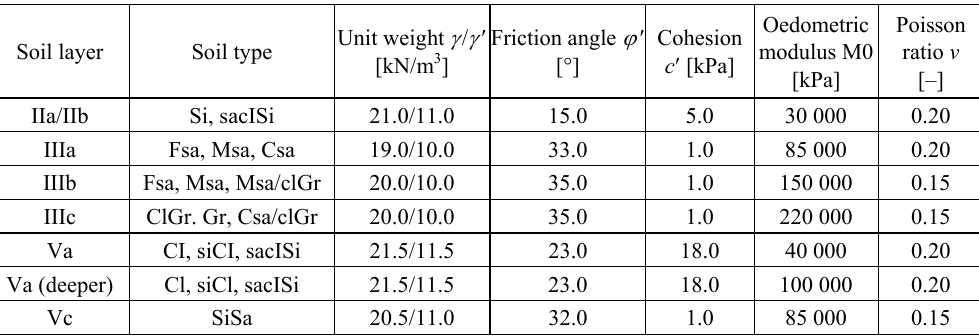
Table 1. Soil geotechnical